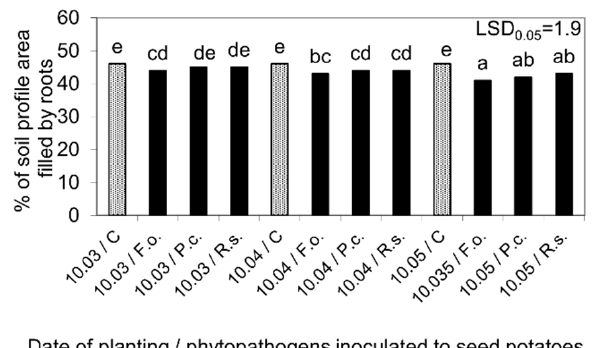
Figure 7. Percentage of the soil profile area filled by the roots 72 days after planting the seed potatoes into the ground, as affected by their storage at 4 ◦ C from harvest until inoculation with phytopathogens on 10 February and then at 15 ◦ C and 80% RH before planting in the soil on 10 March, 10 April, and 10 May. C—Control; Fo— F. oxysporum , Pc— P. corotovorum , Rs— R. solani . Means marked with the same letters do not differ statistically at the significance level p = 0.05. LSD was calculated at the significance level of p = 0.05.